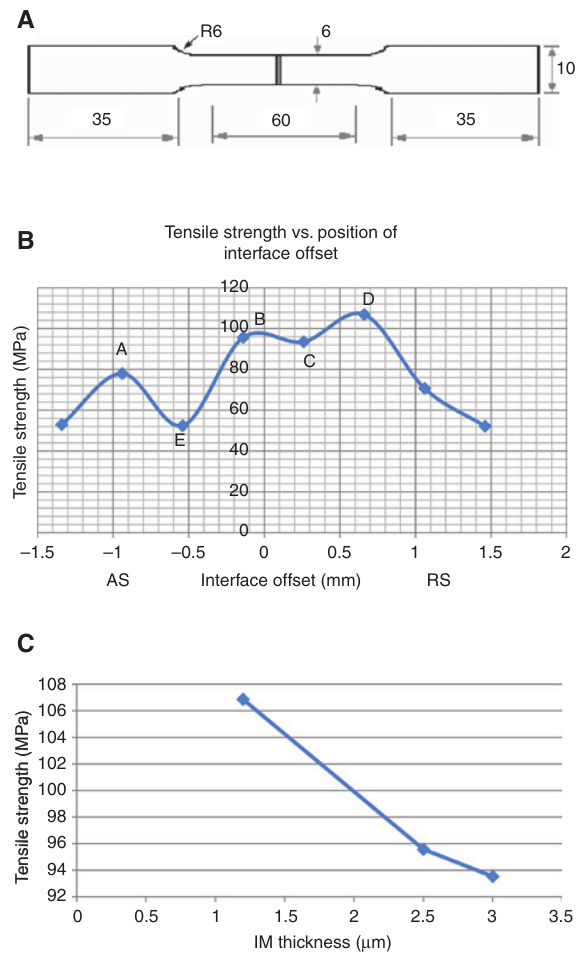
Figure 13: (A) Dimension of tensile sample. (B) Tensile strength of tensile samples at various interface offset positions. (C) Plot of tensile strength versus IM